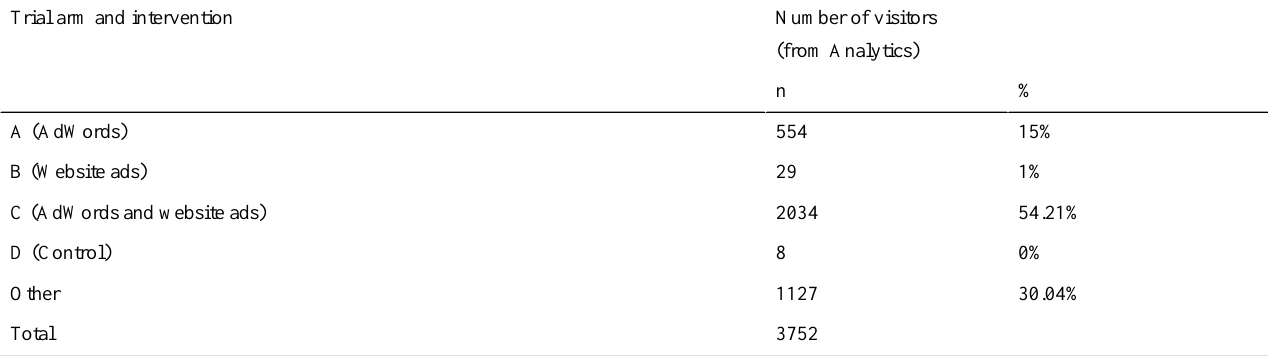
Table 2. Google Analytics data showing total visitors (n = 3752) between June 9 and September 30 (by Cost per Click and other), classified using their town into an arm in the trial or as other area (ie, not in the